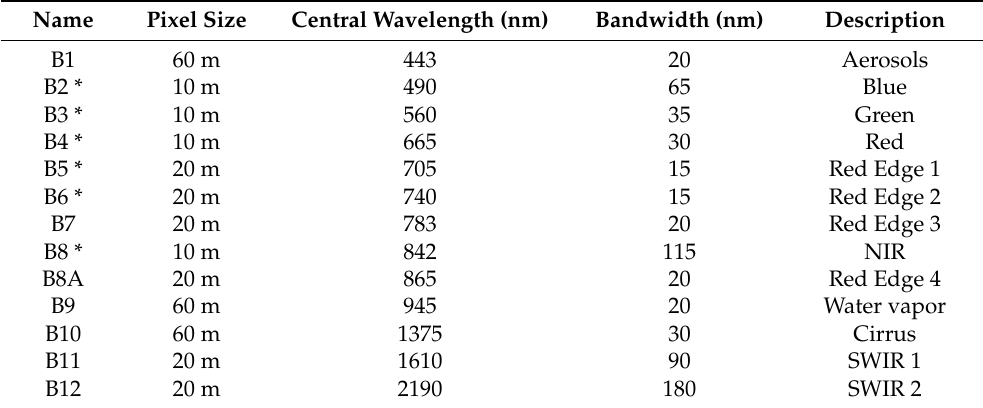
Table 3. The band and spatial resolution information of the Sentinel-2 MSI (* represents the bands used in this